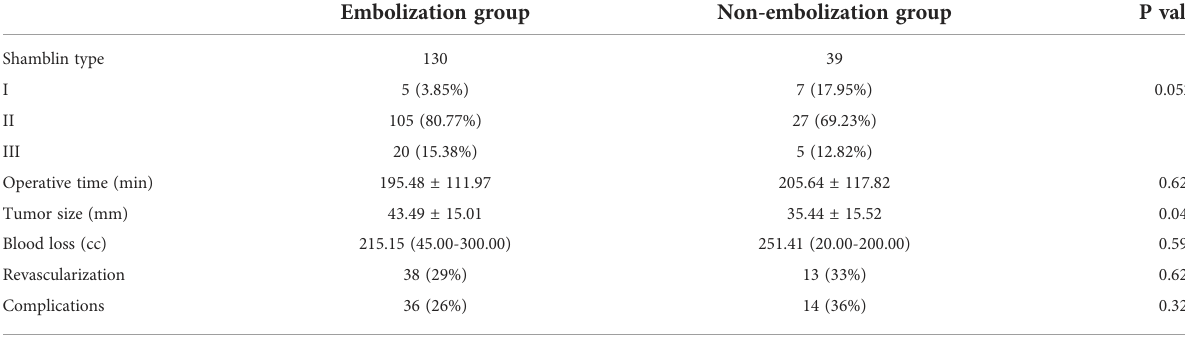
TABLE 2 Tumor and patient characteristics between the embolization group and non-embolization